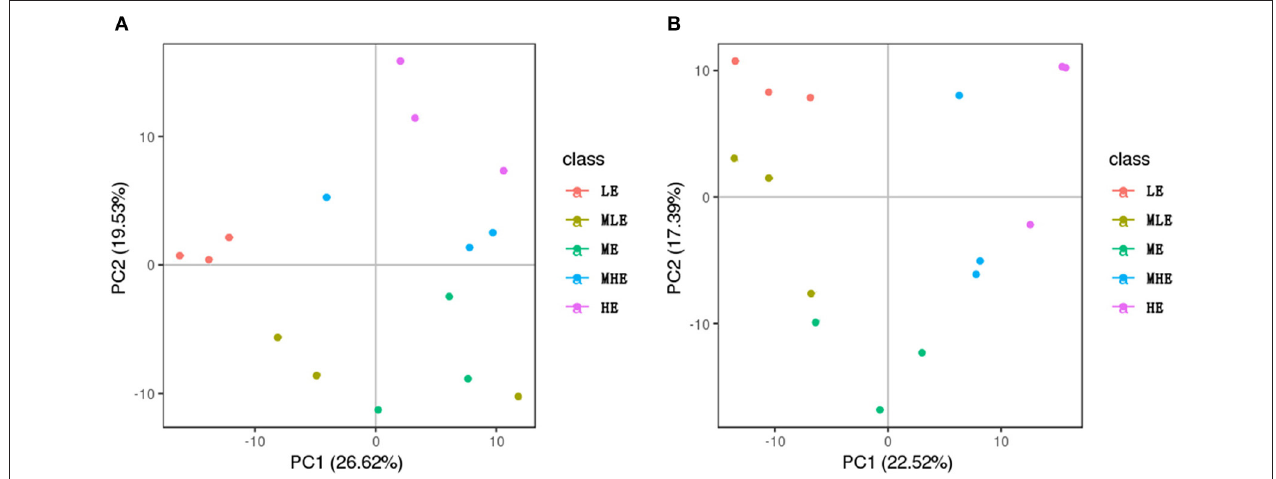
FIGURE 4 | The PCA score plots based on the liver metabolic profiling. (A) Positive mode. (B) Negative mode.